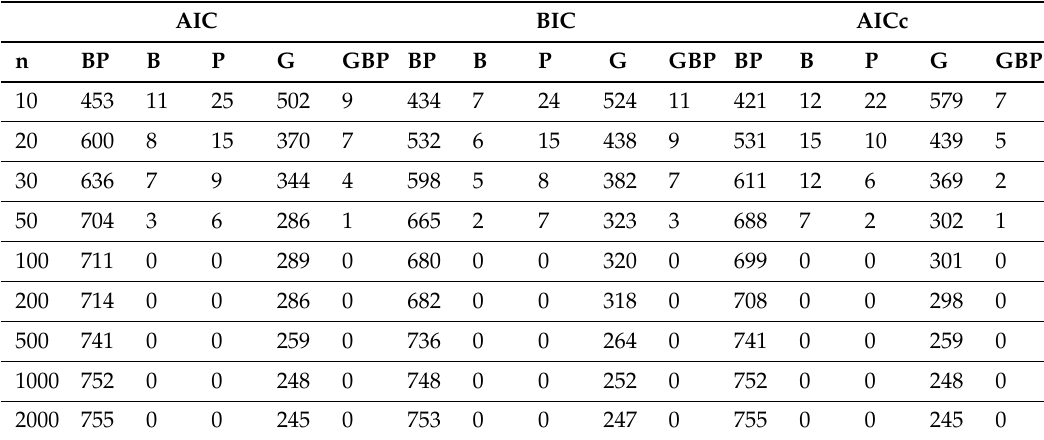
Table 17. Smaller AIC/BIC/AICc scores in 1000 simulations from a censored BP distribution